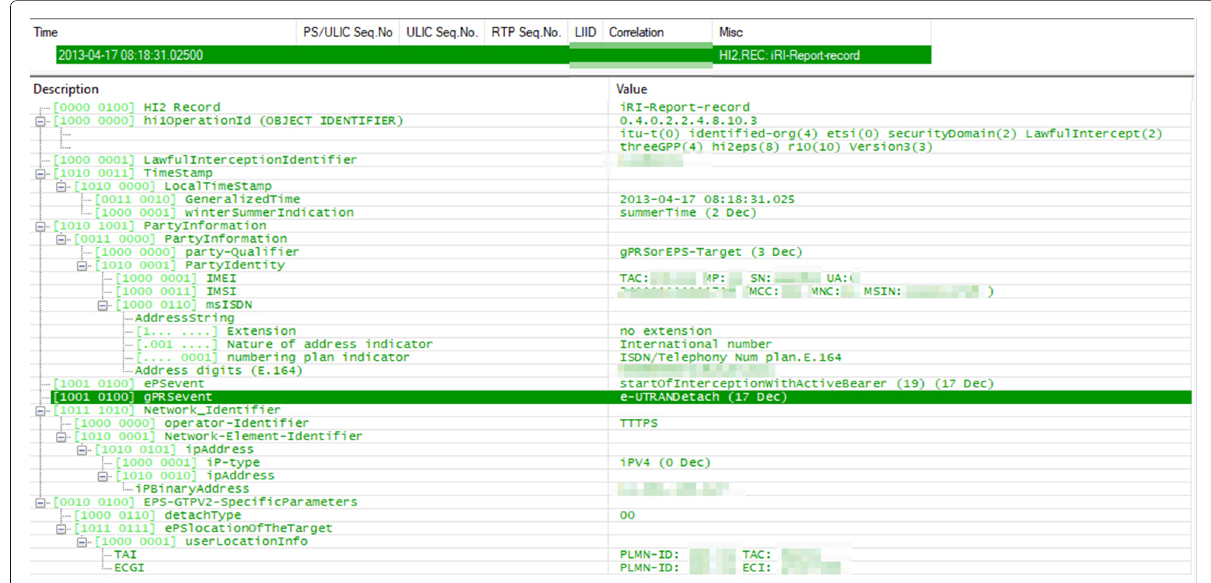
Fig. 3 IRI-REPORT record for an EUTRAN detach event. This is an original IRI record from a cellular network investigation so the correlation number, LLID, IMEI, IMSI, MSISDN, IP address, TAI, and ECGI are blurred to protect the anonymity of the target